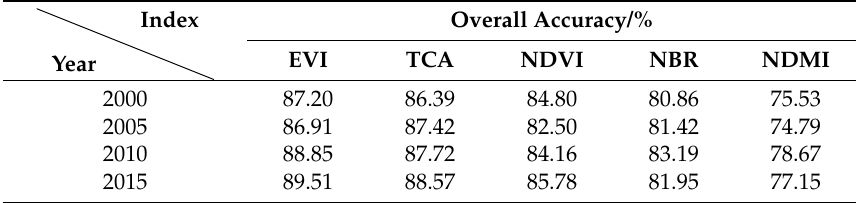
Note: The gray background indicates the maximum value of the corresponding